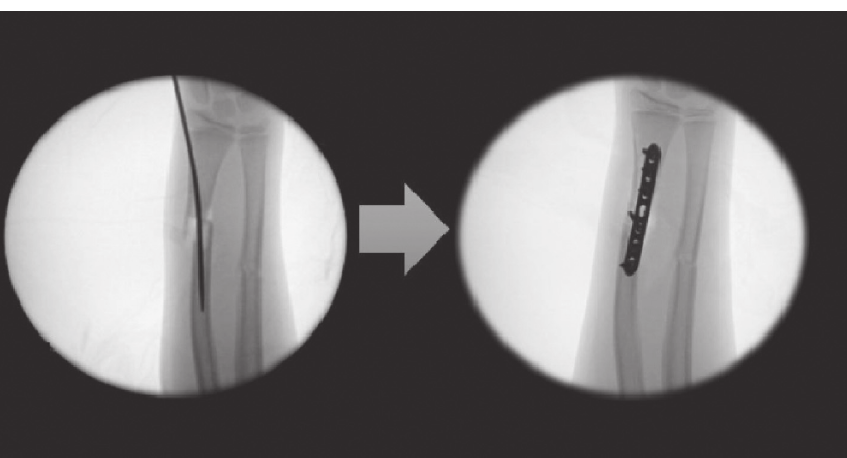
Figure 1: Intraoperative fluoroscopic images showing residual fracture displacement after passage of the FN. The fixation method was changed to plate fixation, and anatomical reduction was obtained.